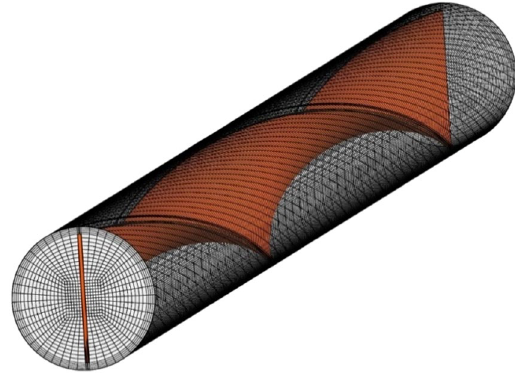
Figure 3. a structured grid for present